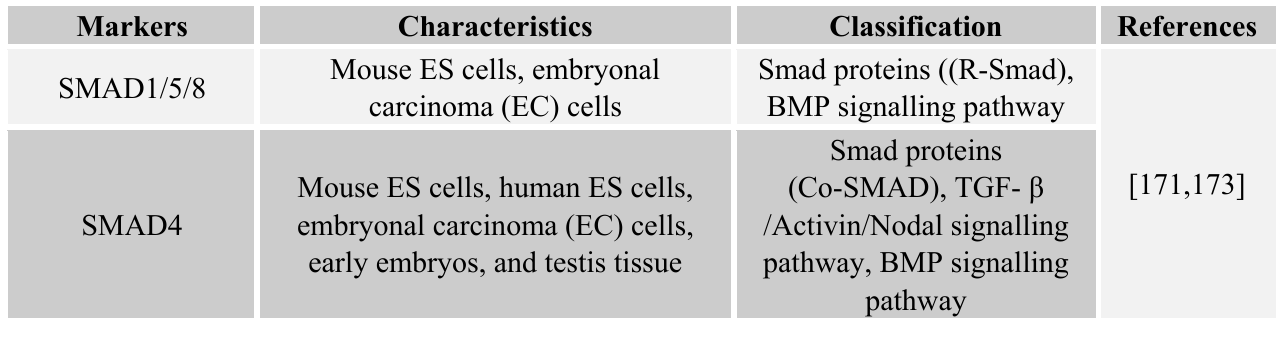
Table 3. Signal pathway-related intracellular